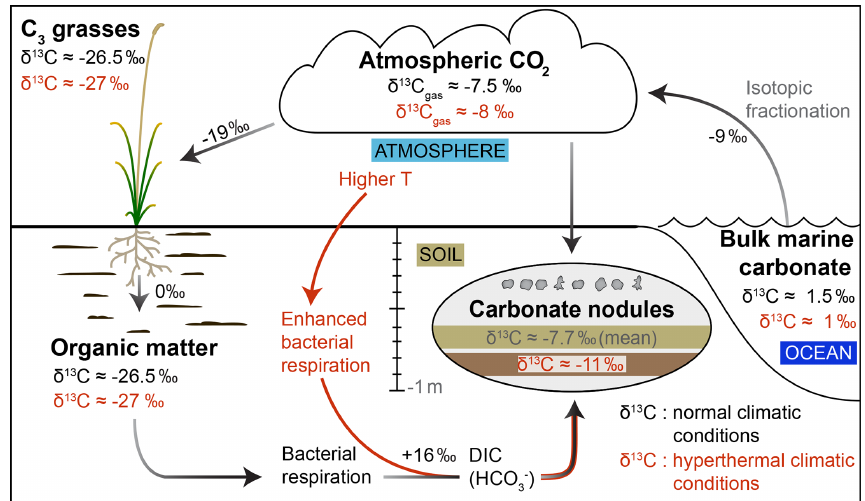
Figure 8. Components influencing the δ 13 C values of pedogenic carbonate nodules. Mean early Eocene bulk marine carbonate and small- scale hyperthermal (all except PETM) are from Westerhold et al. (2018). Fractionation value between organic matter and carbonate nodules are based on Sheldon and Tabor (2009). All other fractionation values are based on Koch et al. (1995). Mean carbonate nodule values come from this